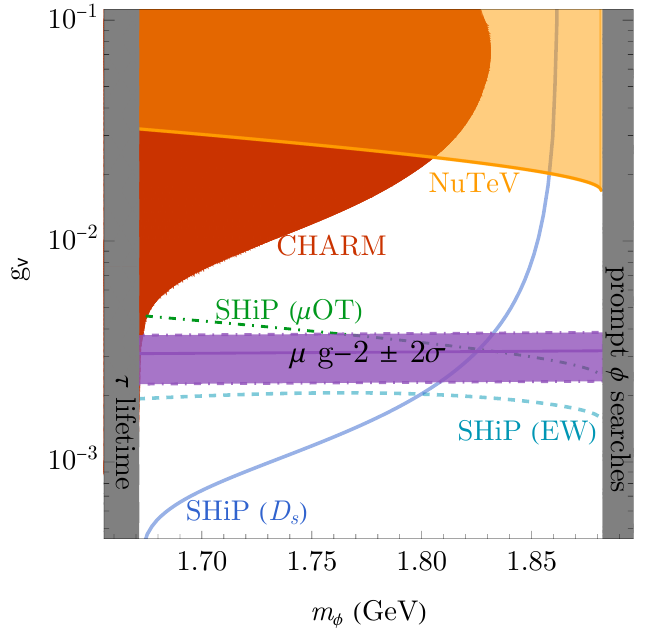
Figure 9 . The existing constraint and projection sensitives in the g V − m φ plane for different